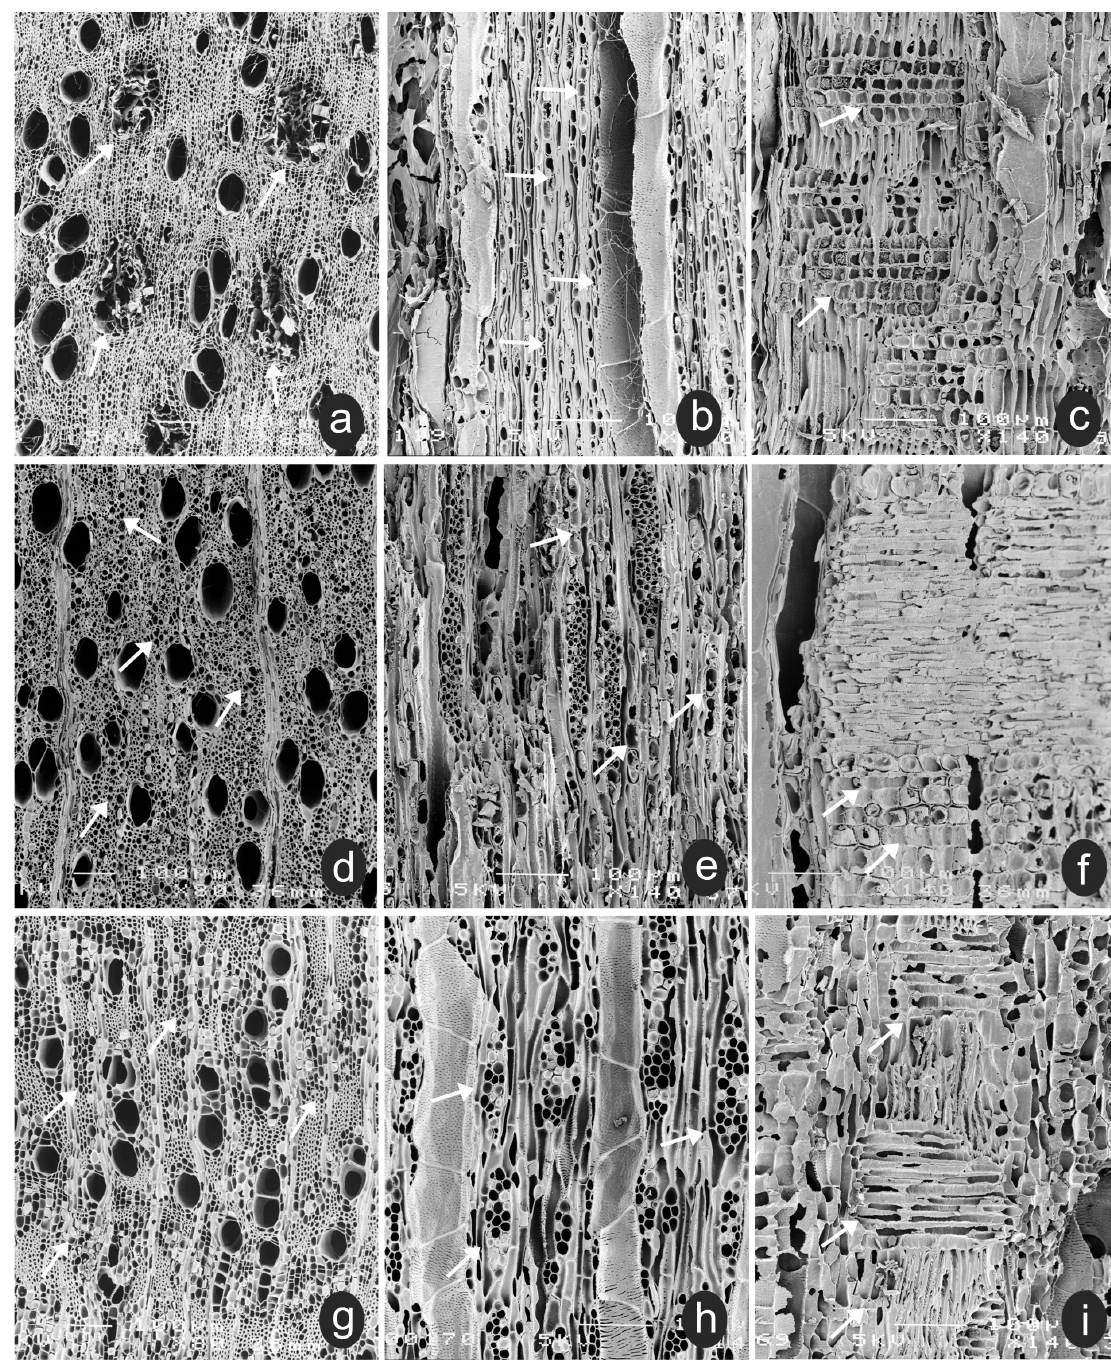
Figure 5. a-b-c. Mouriri chamissoana Cogn. (Melastomataceae / SPw1138) [Arrows: a- included phloem; b- uniseriate rays; c- all ray cells upright or square]. d-e-f. Myrcia minutiflora Sagot. (Myrtaceae / SPSFw2576) [Arrows: d- axial parenchyma diffuse-in-aggregates; e-f- uniseriate portion of multiseriate rays, composed of many rows of square and upright cells]. g-hi Qualea grandiflora Mart. (Vochysiaceae / BCTw11246) [Arrows: g- axial parenchyma; hi rays]. a-d-g: Transverse section. – b-e-h: Tangential section. – c-f-i Radial section. Bars = 100